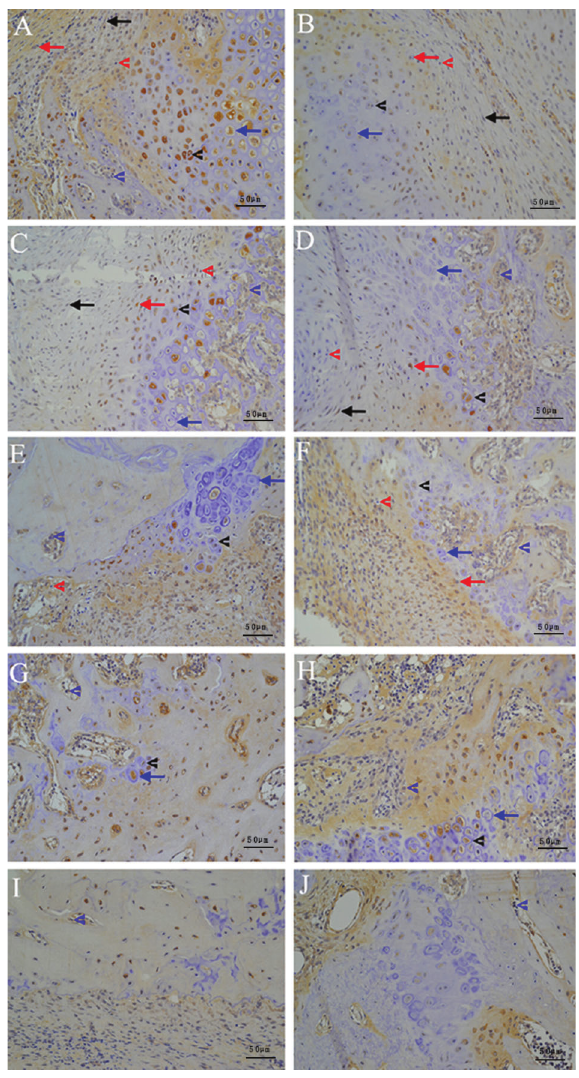
Figure 2. Local expression of transforming growth factor b 1 (TGF- b 1) during fracture healing is shown in the control ( A ) and diabetes ( B ) groups after 1 week of healing, 2 weeks of healing ( C ) and ( D ), 3 weeks of healing ( E ) and ( F ), 4 weeks of healing ( G ) and ( H ), and 5 weeks of healing ( I ) and ( J ), respectively (DAB (cid:1) 200). Red arrows: osteogenic cells; red arrowheads: osteoblasts in the subperiosteal bone; black arrows: fi broblast-like cells; black arrow- heads: proliferating chondrocytes; blue arrows: mature chondro- cytes; blue arrowheads: osteoblasts in the trabecular bone near to endochondral ossi fi cation front.